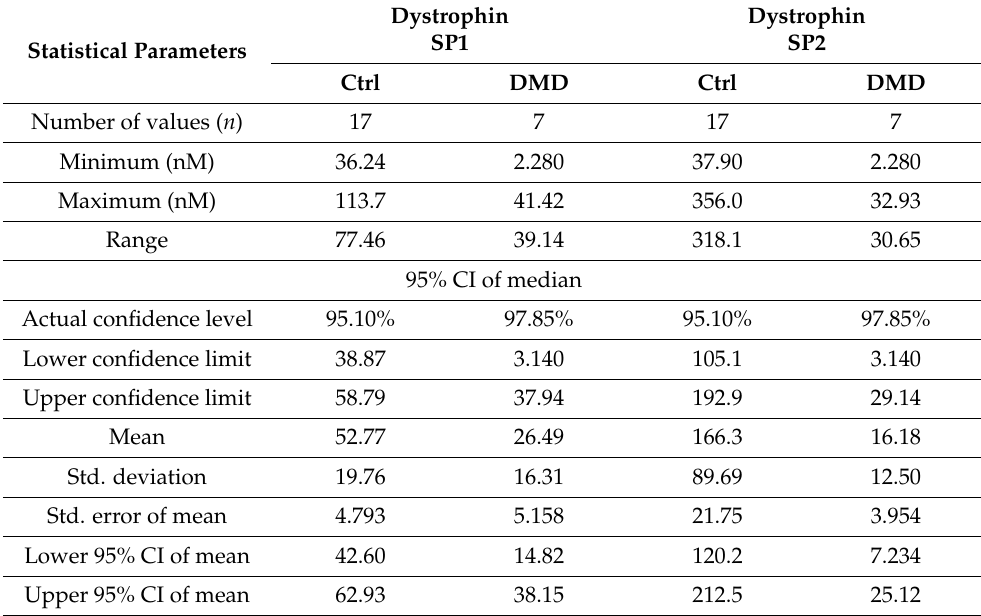
Table 5. Dystrophin protein clinical reference range in nM based on the dystrophin signature peptide concentration in a